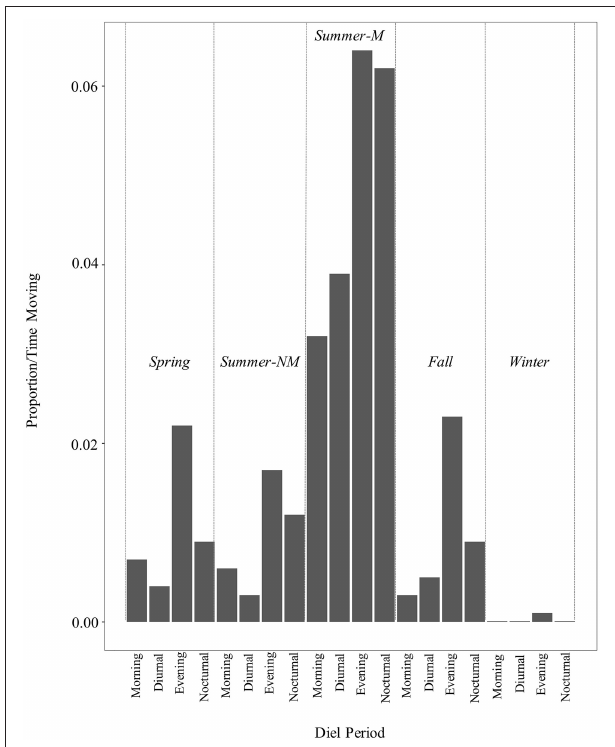
FIGURE 4 | Movement durations (bars denote mean proportion of time classified as “movement” by RF model) within diel periods and seasons over entire ACT logging period for C. atrox ( N 12). Seasons consisted of: Spring = [Apr–May], Summer Non-Mating (NM) [Jun–Jul], Summer-Mating (M)